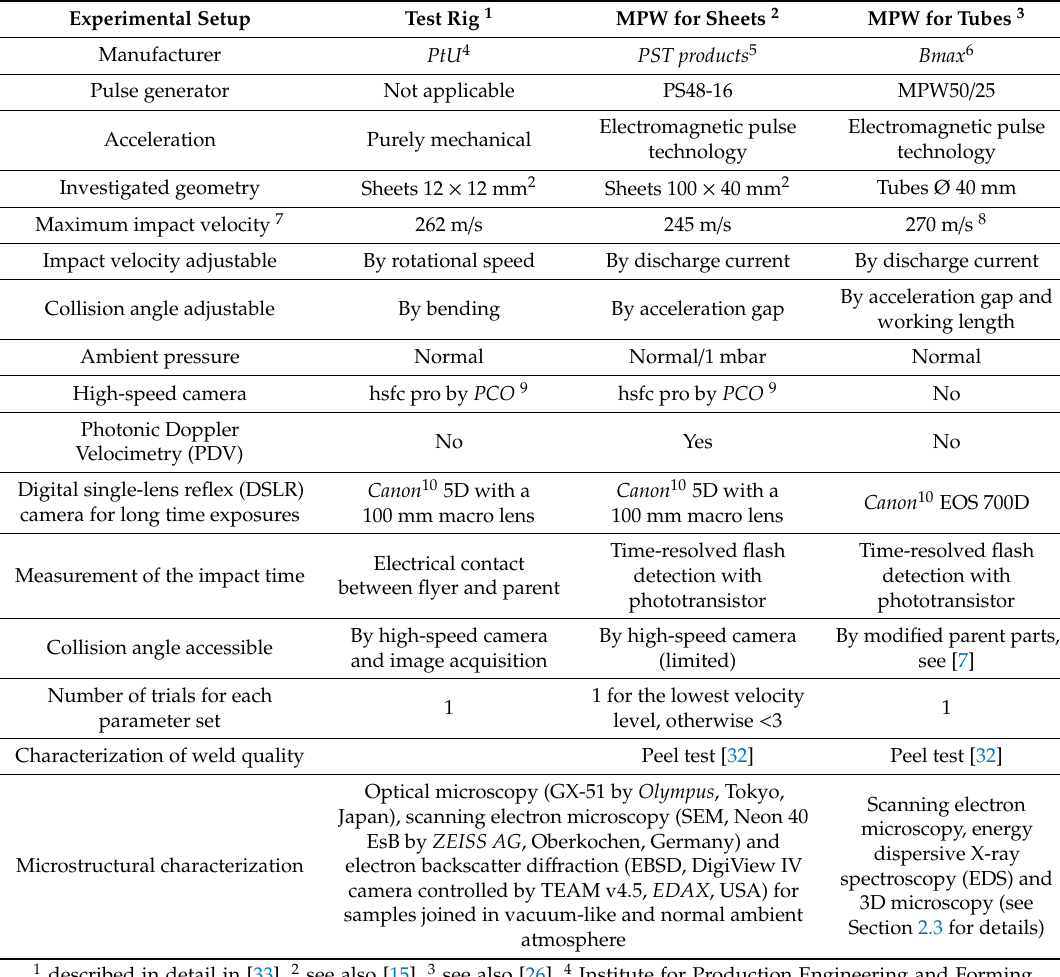
Table 2. Characteristics of the deployed experimental